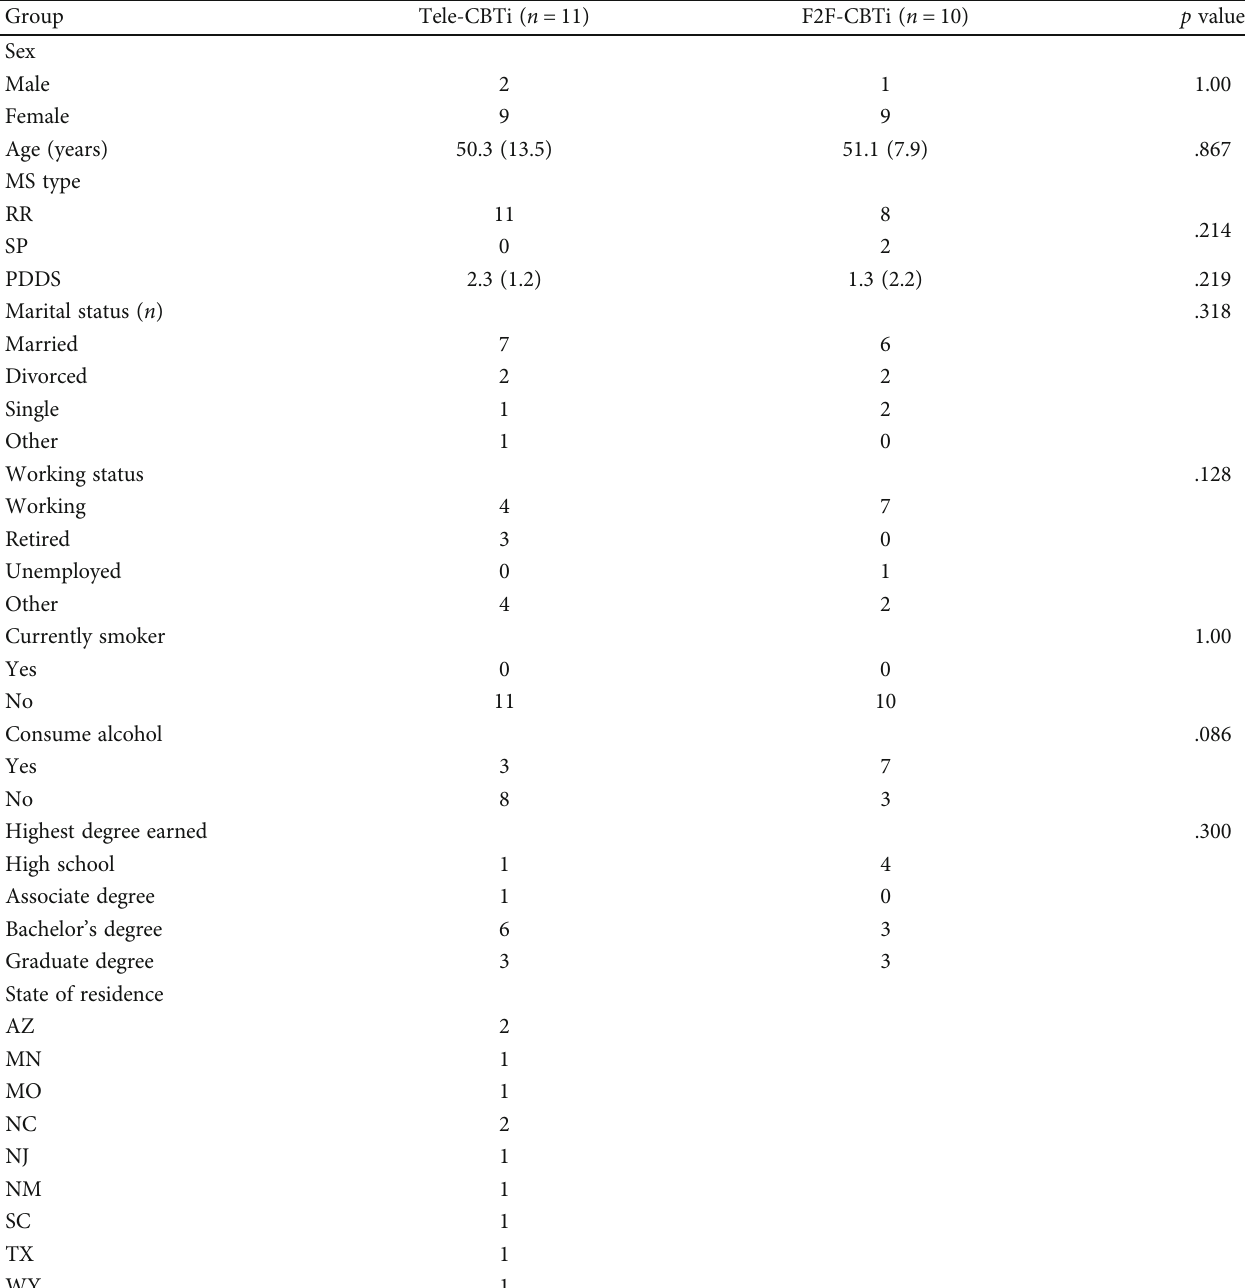
Table 1: Descriptive statistics of the participants. Data reported as mean (standard deviation) or number ( n ). RR: relapsing-remitting; SP: secondary progressive; PDDS: Patient Determined Disease